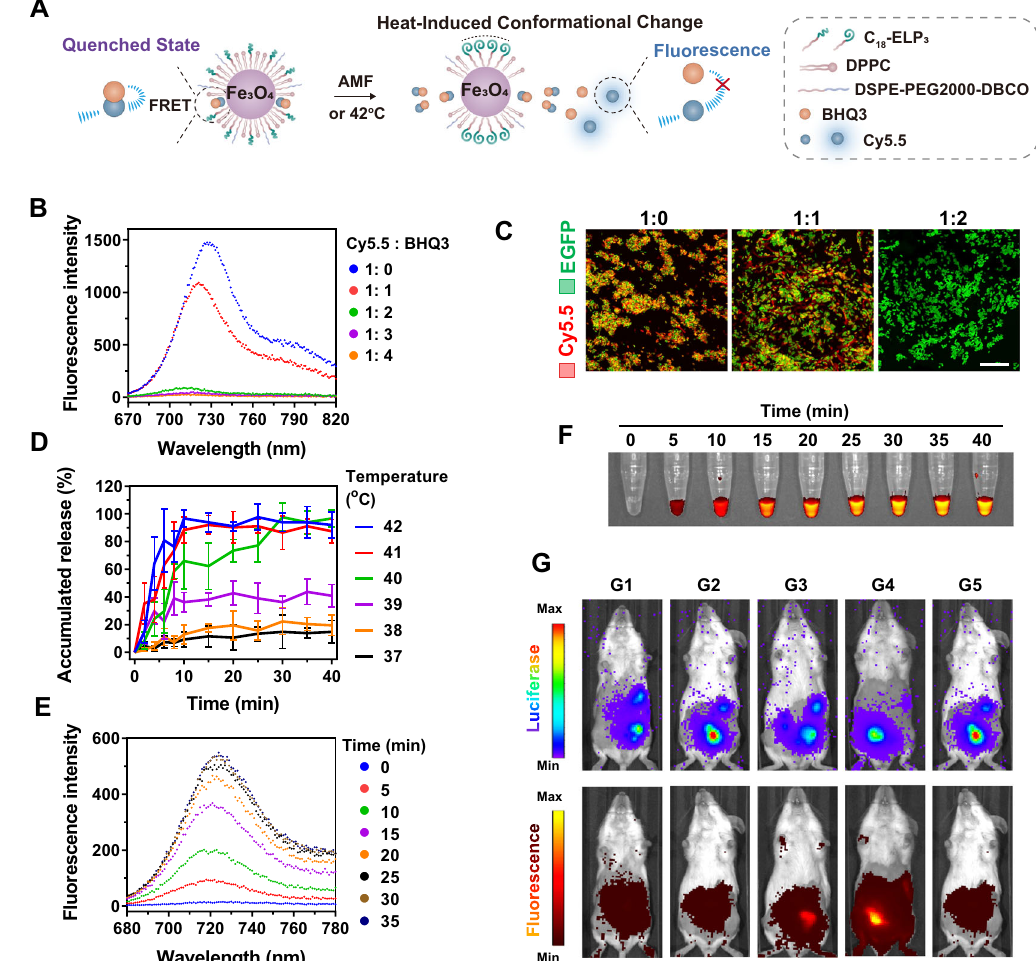
Fig. 3 | Assembly of signal feedback module. A Illustration of signal feedback module for AMF-responsive fl uorescence imaging. Fe 3 O 4 NPs was coated with a monolayerofLTSL(LTSL@Fe),whichwascomposedofDSPE-PEG2000-DBCOand temperature-sensitive lipids, including DPPC and C 18 -ELP 3 . The fl uorescent dye, Cy5.5,anditsblack-holequencher,BHQ3,wereco-loadedintotheLTSLmonolayer (LTSL@Fe/C/B). In the LTSL@Fe/C/B, the fl uorescence of Cy5.5 was quenched by BHQ3, which is recovered by the heat-induced conformational change and Cy5.5 release. B Fluorescenceemission spectraof LTSL@Fe/C/Batdifferent molar ratios of Cy5.5 and BHQ3. C Observation of LTSL@Fe/C/B-Bac-HlpA/EGFP at different molar ratios of Cy5.5 and BHQ3 using CLSM. Bacteria were tracked by EGFP expression. Scale bar, 20 μ m. D The percentage of accumulated release of